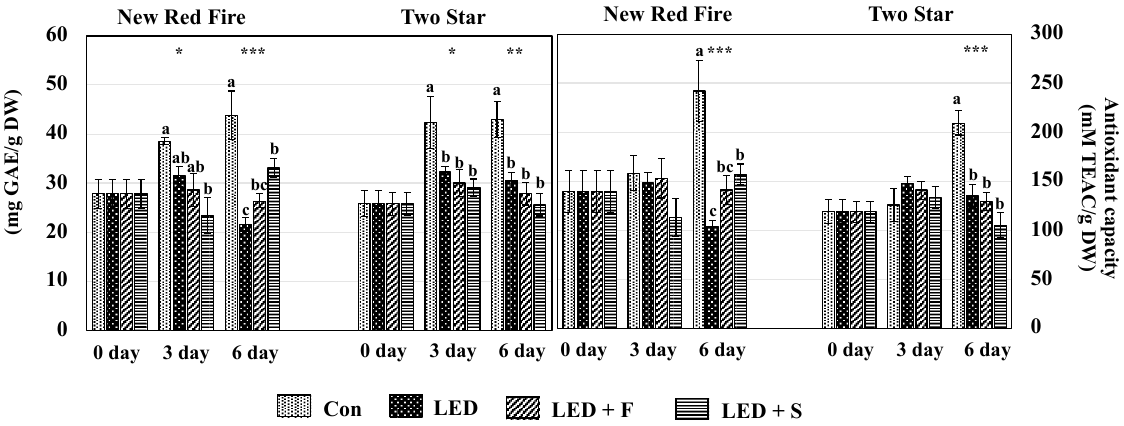
Figure 3. Total phenolic concentration and antioxidant capacity (TAEC, Trolox equivalent antioxidant capacity) of lettuce varieties, ‘New Red Fire’ and ‘Two Star’, subjected to supplemental UV-A radiation. Treatments included LEDs, LEDs + focus lens (LED + F), LEDs + scatter lens (LED + S), and control (Con). Measurements were made at 0, 3, and 6 days of treatments. Vertical bars indicate standard errors (n = 4). Bars with different letters are significantly different. Significant differences are presented at p < 0. 05 (*), p < 0.01 (**), and p < 0.001 (***).